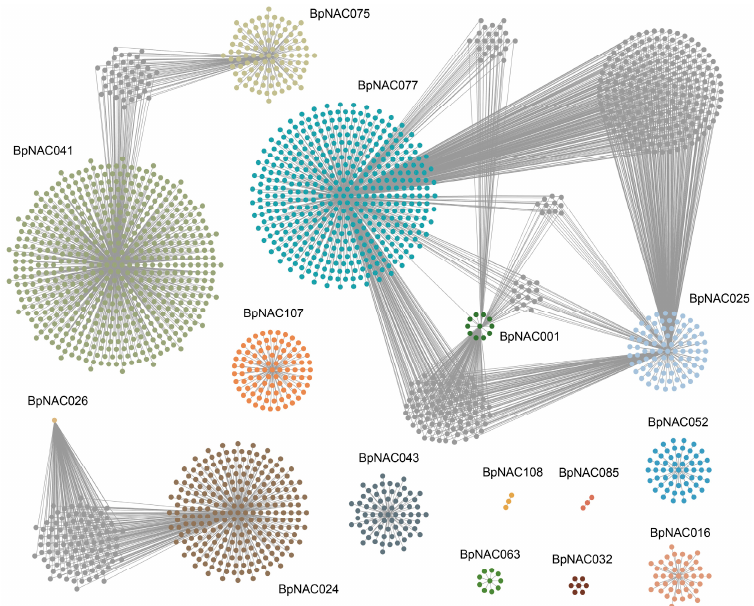
Figure 4. TF-centered co-expression network for the 15 low-temperature response BpNACs . Made by WGCNA and Cytoscape with a weight threshold of 0.1.